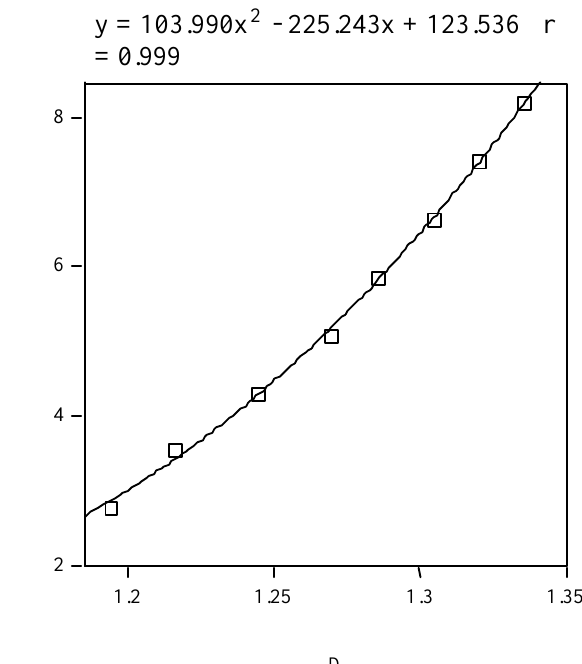
Figure 4. Molar concentration of homologous phenyl alcohols necessary to produce a 1:1 complex with BSA via equilibrium dialysis vs . the fractal dimension.